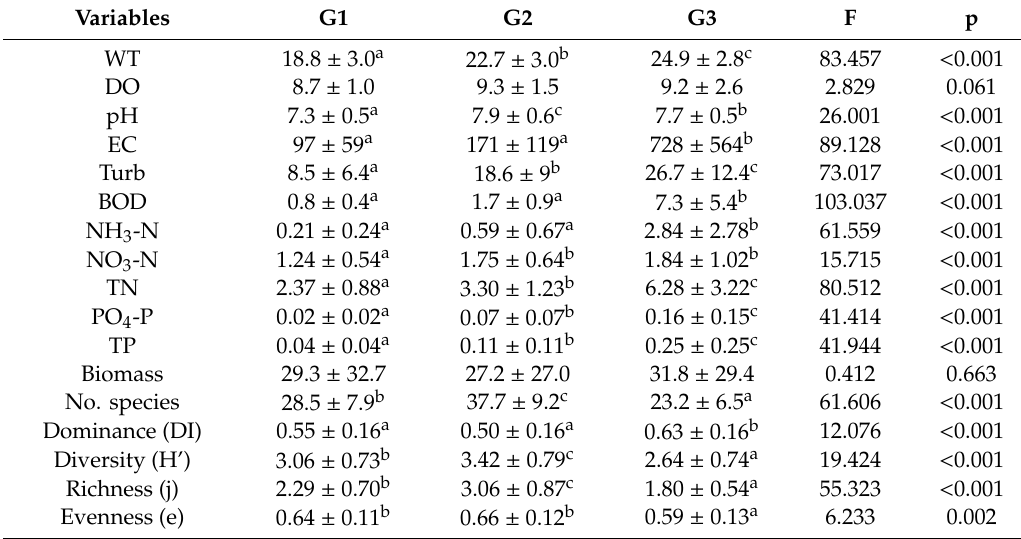
Table 1. Physicochemical and biological variables of the epilithic diatom communities (G1–3) in the Hantangang River, from 2012 to 2015.